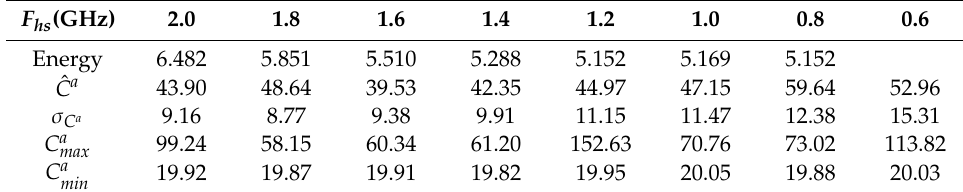
Table 7. Interactive governor with configuration 1 and di ff erent F hs values. Vid2.